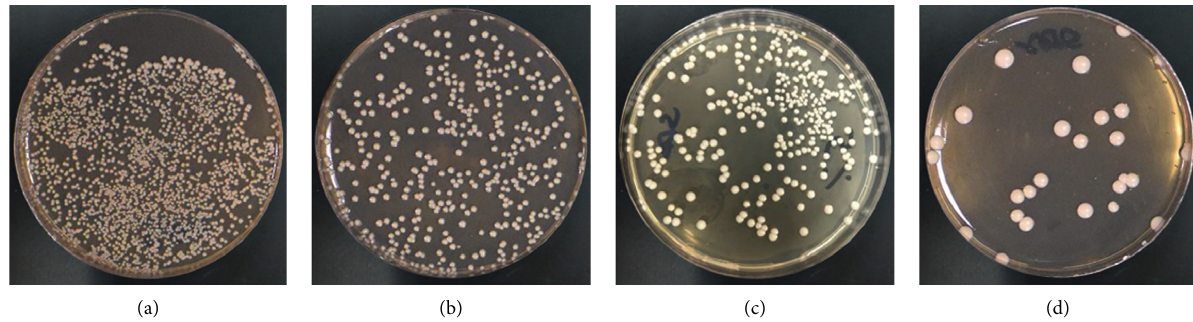
Figure 2: Direct culture method based on different ZrO 2 NP concentrations of heat-polymerized acrylic resin. (a) Control; (b) 1% ZrO 2 NPs;